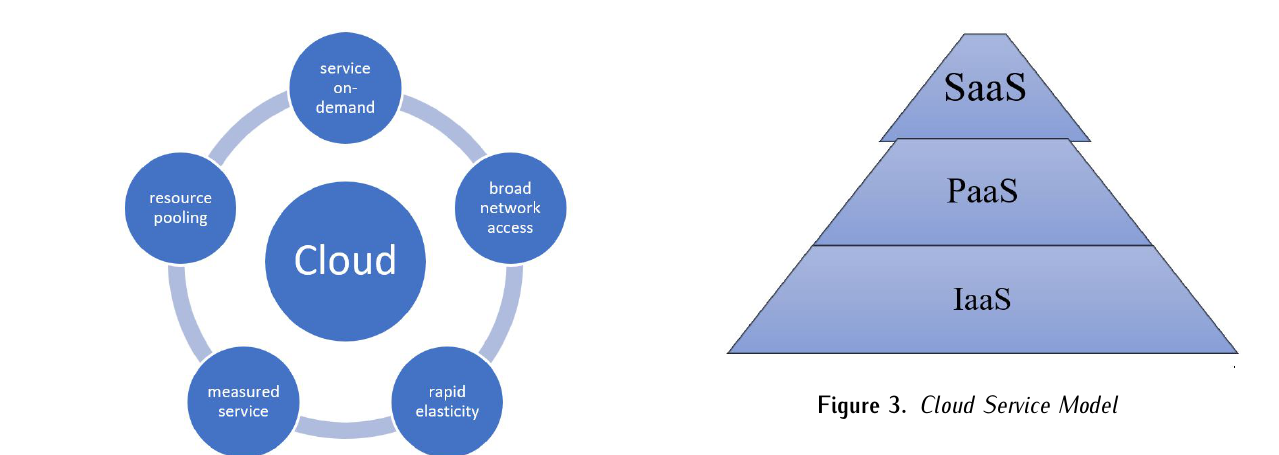
Figure 2. Cloud characteristics